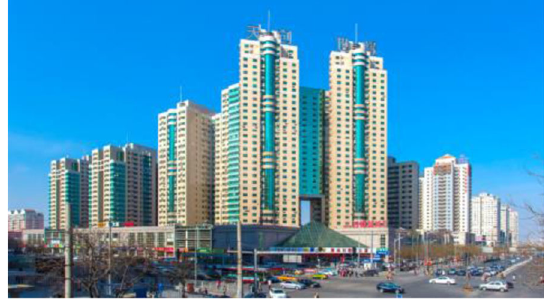
Fig. 10 Tianchuang Shiyuan